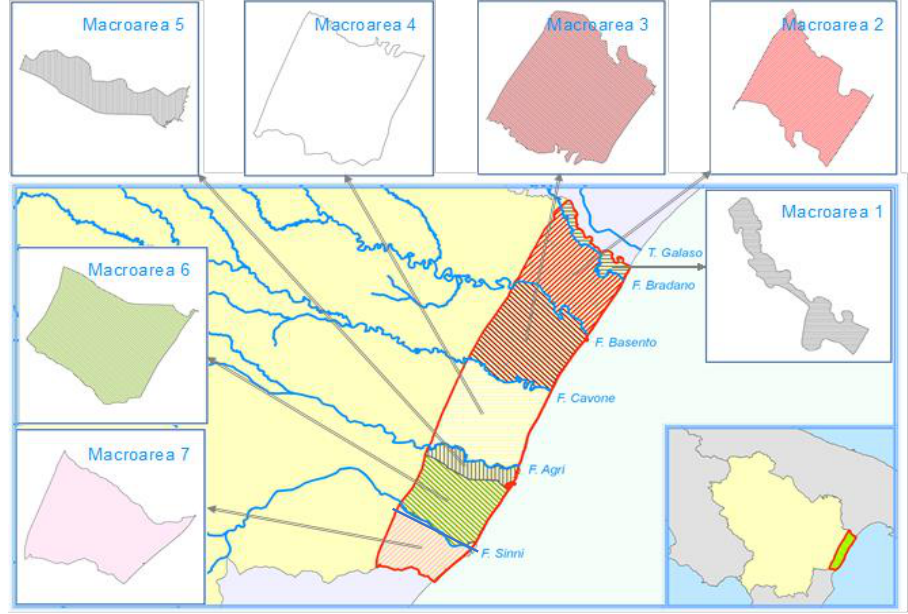
Figure 2. The macro-areas of the Ionian Basilicata coastal zone and the different transects used in this study.